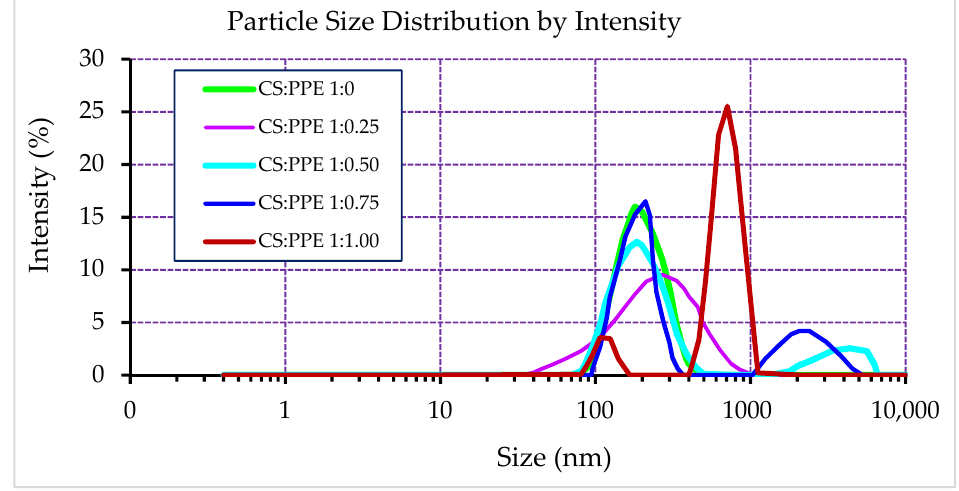
Figure 1. Intensity-based particle size distribution of CSNPs at different chitosan:PPE weight ratios.